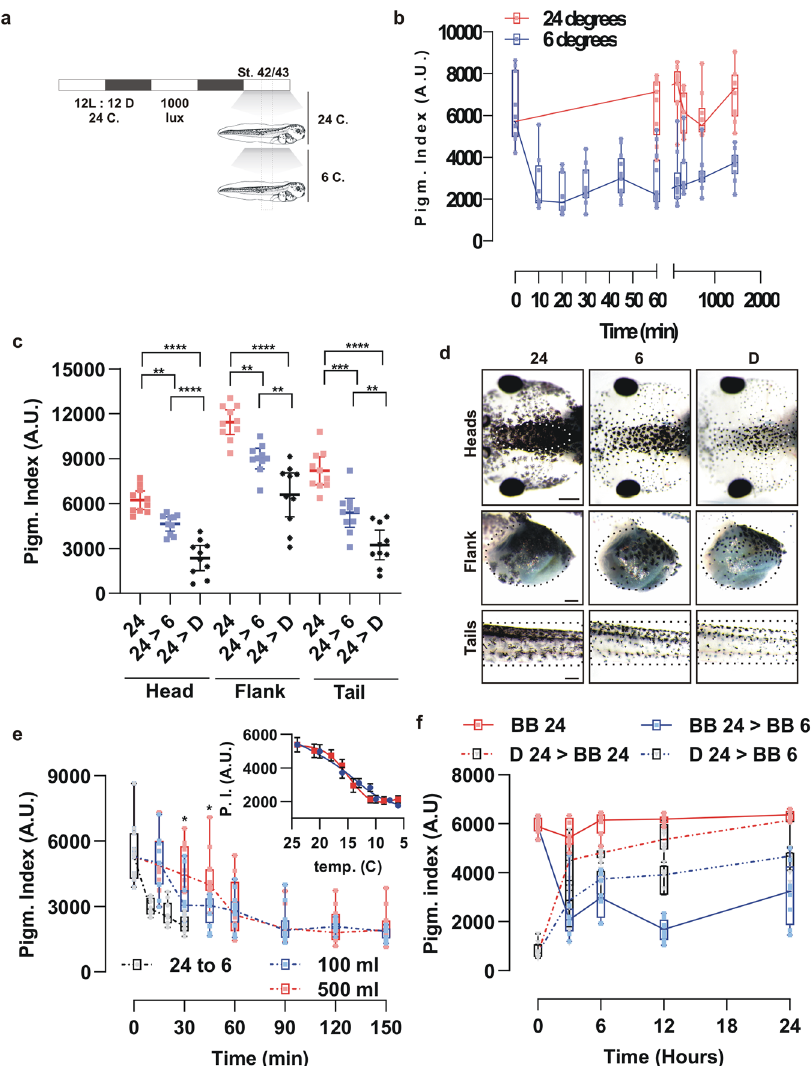
Fig. 2 Colour change induced by cooling is a systemic response mediated by a fast and temperature-dependent movement of melanosomes in skin melanophores. a Schematic representation of the experimental approach. Embryos were raised on a 12 h ON/12h OFF cycle until stage 42/43 with light shining from above (1000 lux). Embryos were maintained at 24°C for at least two days prior to reaching stage 42/43. Analysis of the effect of temperature on skin pigmentation was performed at approximately the middle of the light phase cycle (rectangle), by switching to bathing media at 6 °C, while keeping constant the overhead light and surface colour. b Pigmentation index quanti fi ed from digital images of the dorsal head of Xenopus embryos at different times after being moved from 24 °C (red dots and lines) to 6 °C degrees (blue dots and lines) [individual data points ( n = 9 embryos) and a box plot (25th to 75th percentile) are represented; N = 3 independent experiments]. c , d Comparative pigmentation index ( c ) and pictures ( d ) of the dorsal head, lateral belly ( fl ank) and the tail of tadpoles at 24 °C (red dots) or 6 °C (blue dots), or switched to dark (black dots) conditions at 24 °C (D; dark) for 30 min (horizontal bar represented the mean ± 95% CI; n = 10 embryos; N = 3 independent experiments). Scale bar = 0.2 mm. e Head pigmentation index of tadpoles in 100 ml (blue dots and dashed line) or 500 ml (red dots and dashed line) containers at 24 °C moved to a 6 °C incubator. The solution temperature was monitored over time and is plotted vs. the pigmentation index (P.I.); blue: 100 ml; red: 500 ml; (Insert). Tadpoles switched from a 24 to 6 °C solution, as shown in 2 A, are also indicated (24 to 6; black dots and dashed line) [individual data points ( n = 10 embryos) and box plot (25th to 75th percentile); N = 3 independent experiments]. f Temperature response (24 °C -red- to 6 -blue- °C) over time as quanti fi ed by the head pigmentation index of tadpoles previously adapted to either a black background (BB; solid lines) (darker embryos; melanosome dispersed) or dark conditions (D; dashed lines) (lighter embryos; melanosome aggregated). [individual data points ( n = 8 embryos) and box plot (25th to 75th percentile); N = 2 independent experiments); ** p < 0.01, *** p < 0.001; **** p < 0.0001; ANOVA followed by Bonferroni ’ s test. * p < 0.05 t